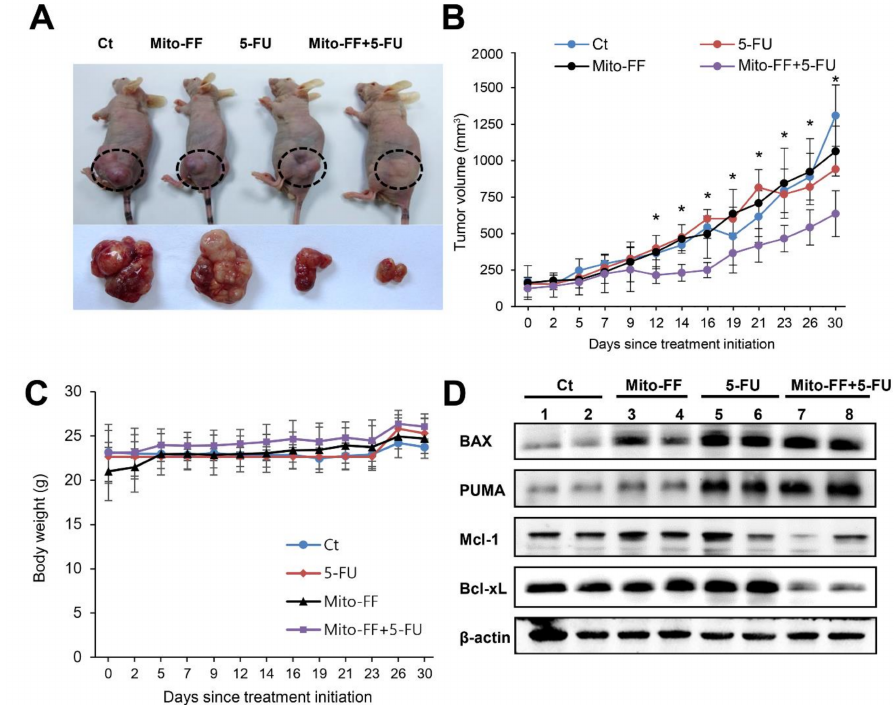
Figure 4. E ff ects of combination therapy on AGS cell growth xenografted in nude mice. The nude mice were intraperitoneally injected with 5-FU (1.25 mg / kg), Mito-FF (50 µ g / kg), or both 3 times a week for 4 weeks. Subsequently, the tumors in the mice were collected after euthanizing them. ( A ) Photographs showing gross morphology of mice with xenografted AGS cells in each group. The reduction of tumors was most prominent in the mice treated with combination therapy, which was followed by 5-FU and Mito-FF treatments. ( B ) Tumor size after each treatment. Tumor size refers to the longest axis of the extracted tumor. Combination therapy induced the most significant reduction in the tumor size. ( C ) Body weight changes during experiment. The average body weight of mice in each group did not vary significantly over the course of the experiment. ( D ) Western blot analyses of tumor specimens in each group. Combination therapy most significantly increased the expression of a pro-apoptotic marker (Bax and PUMA) and decreased the expression of anti-apoptotic markers (Mcl-1 and Bcl-xL). Values are presented as mean ± standard deviation of three independent experiments. * P <